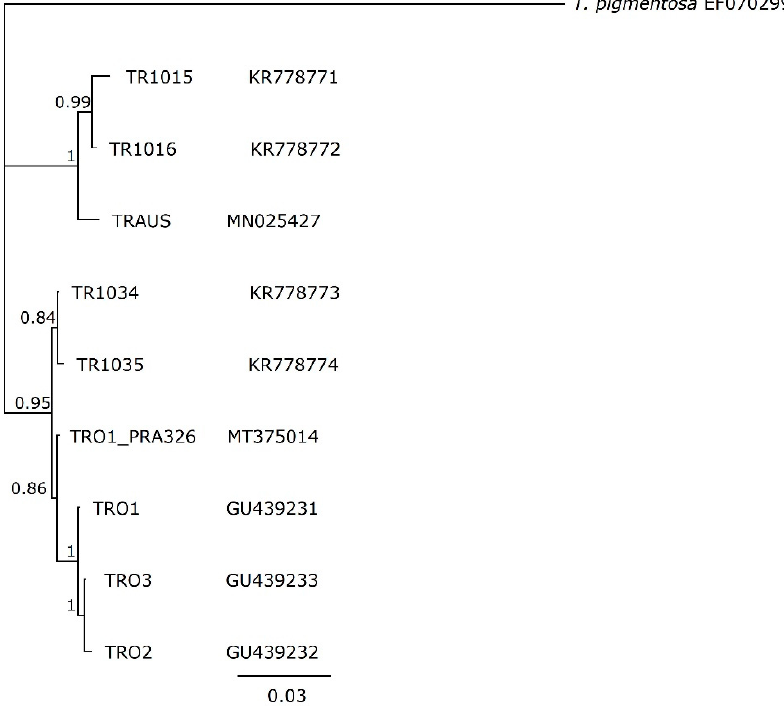
Figure 5. Secondary structures of the central repeat region of T. rostrata TR01 and TRAUS and other